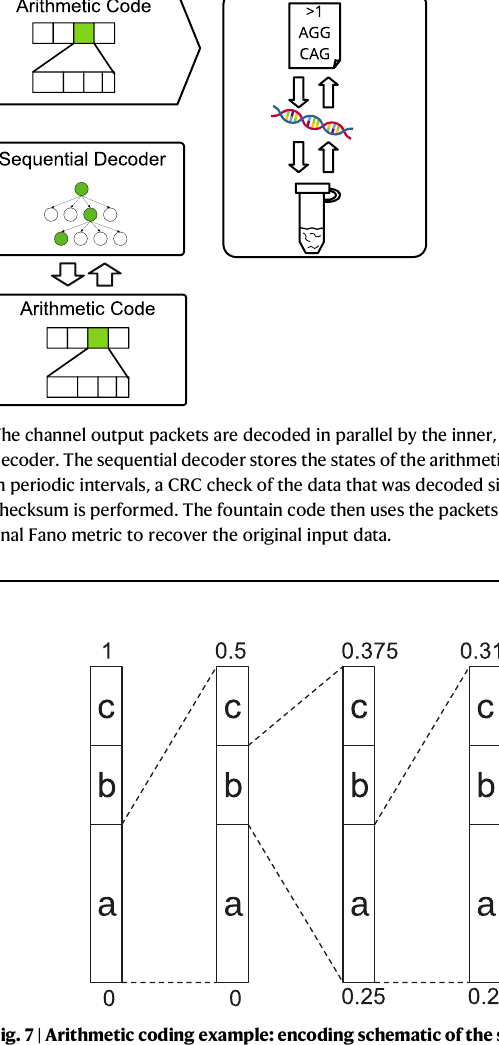
Fig.7|Arithmeticcodingexample:encodingschematicofthestringabacwith probabilities a :0.5, b :0.25, c :0.25. After encoding the fi nal symbol c, the fi nal subinterval is